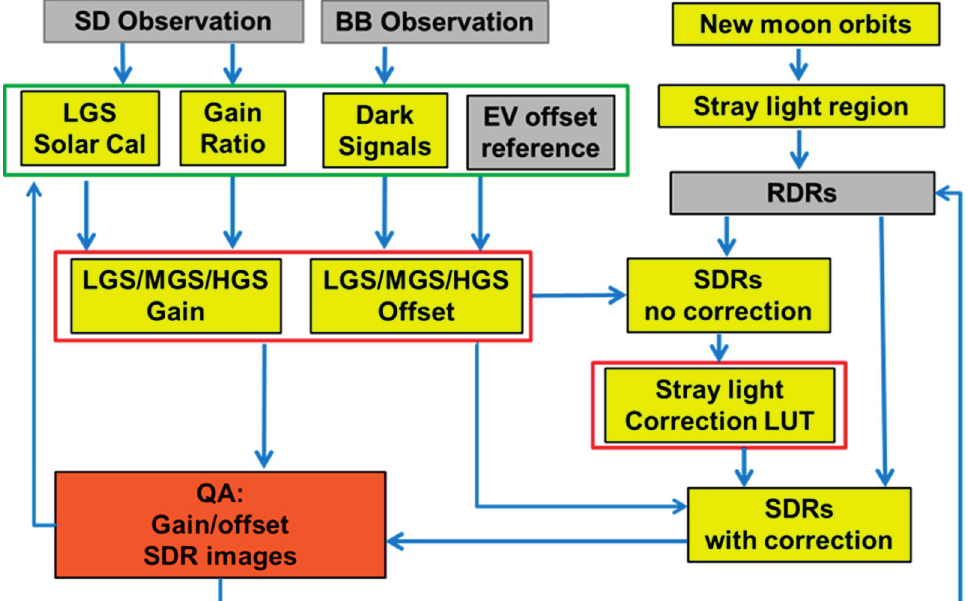
Figure 1. NASA day-night band (DNB) calibration framework. The red boxes indicate the deliverable or the required look-up tables (LUTs) to generate DNB sensor data records (SDRs). SD, Solar Diffuser; BB, blackbody; LGS, low gain stage; MGS, intermediate gain stage; HGS, high gain stage; EV, Earth view. In the diagram, Cal, Calibration, RDR, Raw Data